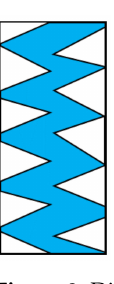
Figure 8. Diagram showing areas with an abrupt change in the direction of